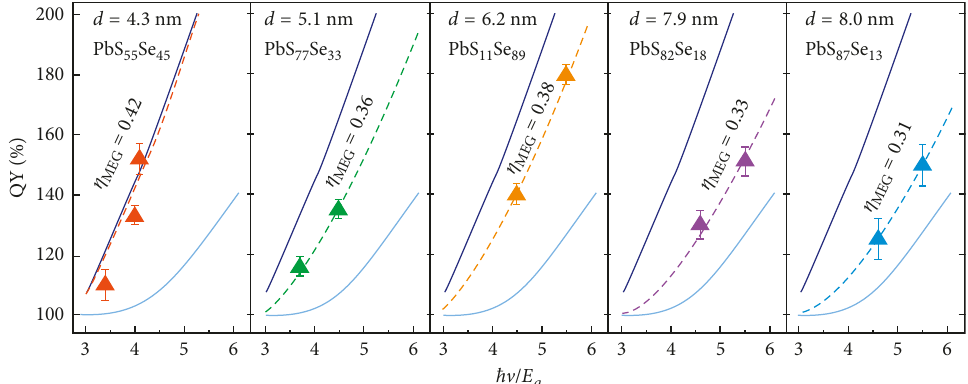
Figure 5: QYs for different sizes of PbS x Se 1 − x alloy QDs from [44] plotted against the standardised pump energy. The solid dark line is showing the QYs for PbSe QDs, while the light blue line is for bulk PbS. The dotted lines are least-squares best fit lines for the alloy